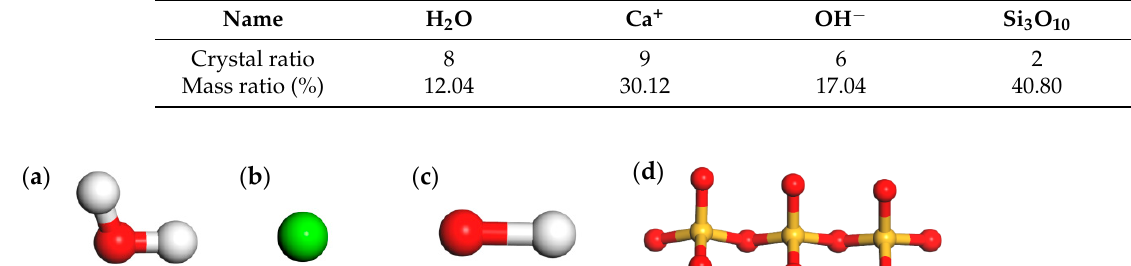
Table 2. Proportions of C-S-H gel composition.